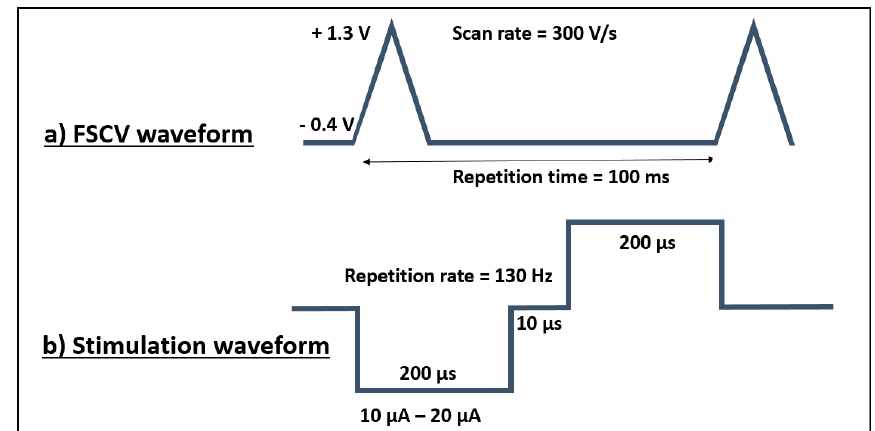
Figure 3. Schematic of the used waveform for electrical stimulation and for fast scan cyclic voltammetry; ( a ) Fast scan cyclic voltammetry (FSCV) waveform, the 100 ms delay with the − 0.4 V holding potential increases the possibility of accumulation of the dopamine molecules prior each scan, the temporal resolution of the detection system is limited by the delay time between two scans; ( b ) biphasic, charged balanced, cathodic first waveform used for the pulse test.